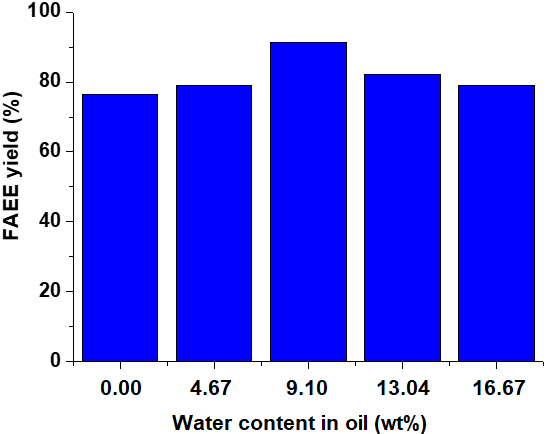
Figure 5. Effect of water content on immobilized lipase-catalyzed transesterification of crude Jatropha curcas L. oil. Experimental parameters: Jatropha oil mass: 10 g; oil to ethanol mass ratio: 1:10; immobilized lipase CALb mass: 4.2 g; reaction temperature: 35 °C; and reaction time: 24 h.